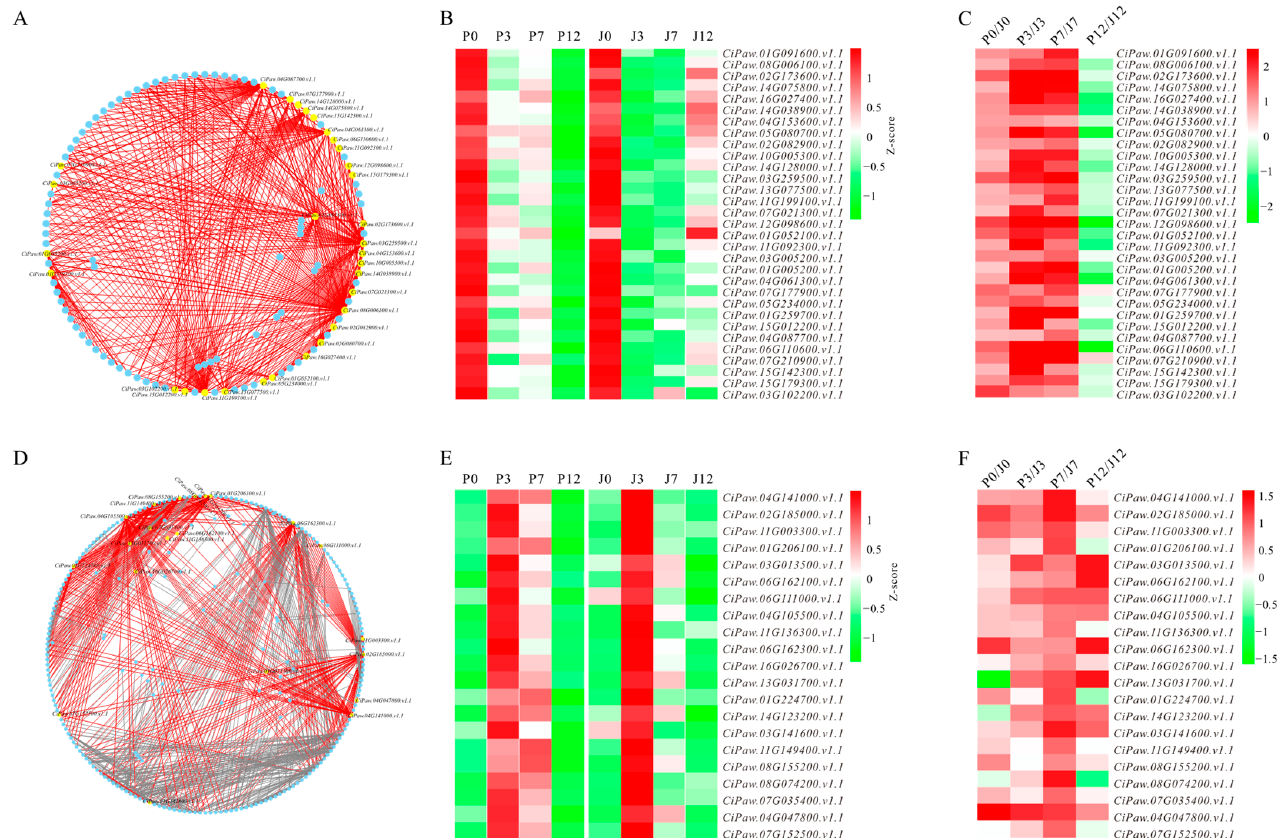
Figure 6. Hub genes and expression patterns. ( A ) Gene co-expression network. ( B ) Expression profiles of hub genes. ( C ) log2 transformed fold changes of hub genes between ‘Pawnee’ and ‘Jinhua’ in tan module. ( D ) Gene co-expression network. ( E ) Expression profiles of hub genes. ( F ) log2 transformed fold changes of hub genes between ‘Pawnee’ and ‘Jinhua’ in green module. Note that only genes with high co-expression (weight > 0.15) are used for network construction. For the network, yellow nodes are the identified hub genes and red edges represent the connections of hub genes. Mean expression levels are used for profile detection and fold change comparison. Expression profiles within each cultivar are independently z-score normalized (b and e). P0 to P12 indicates ‘Pawnee’ expressions at 0 to 12 days after grafting. J0 to J12 indicates ‘Jinhua’ expressions at 0 to 12 days after